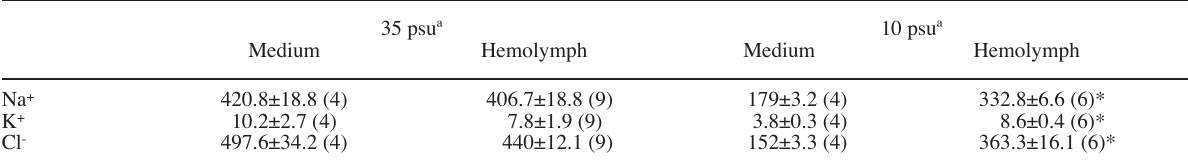
able 1. – Concentration of ions (meq l -1 ) in external medium and in C. angulatus hemolymph.